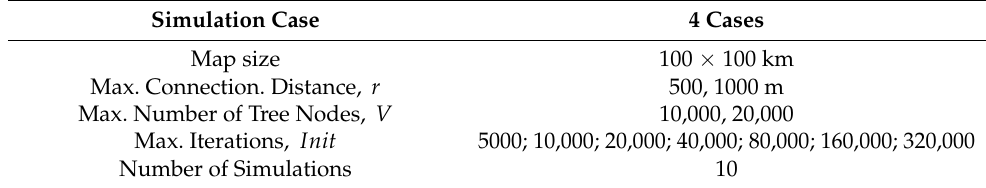
Table 4. Components of the route-planning